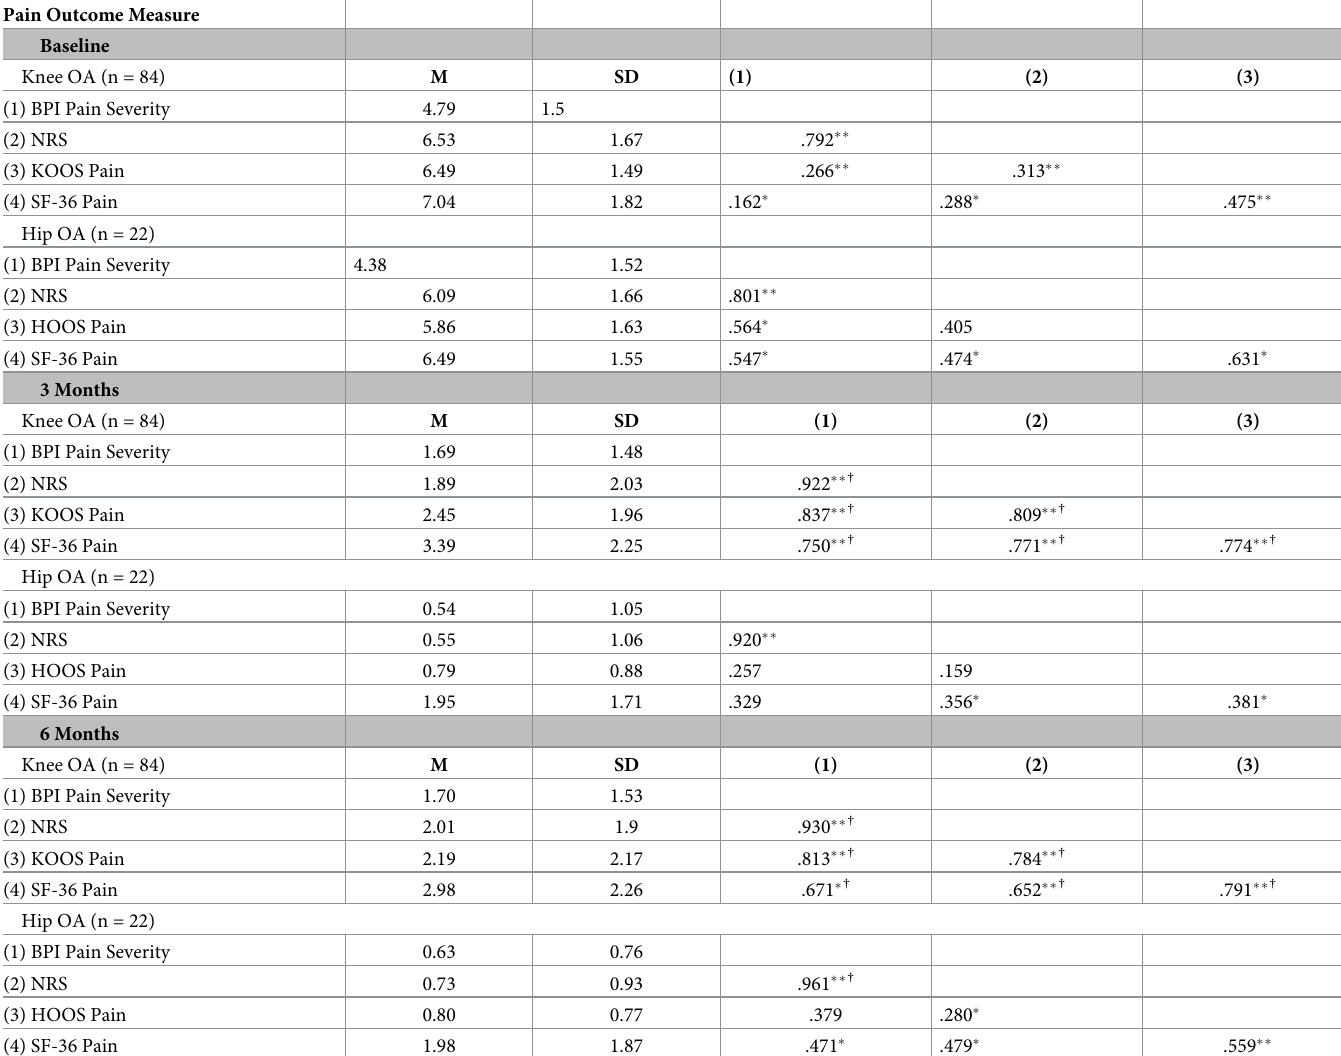
Table 2. Pain in KOA and HOA patients pre- and post-surgery, characterized with four pain outcome measures. Pain Outcome Measure